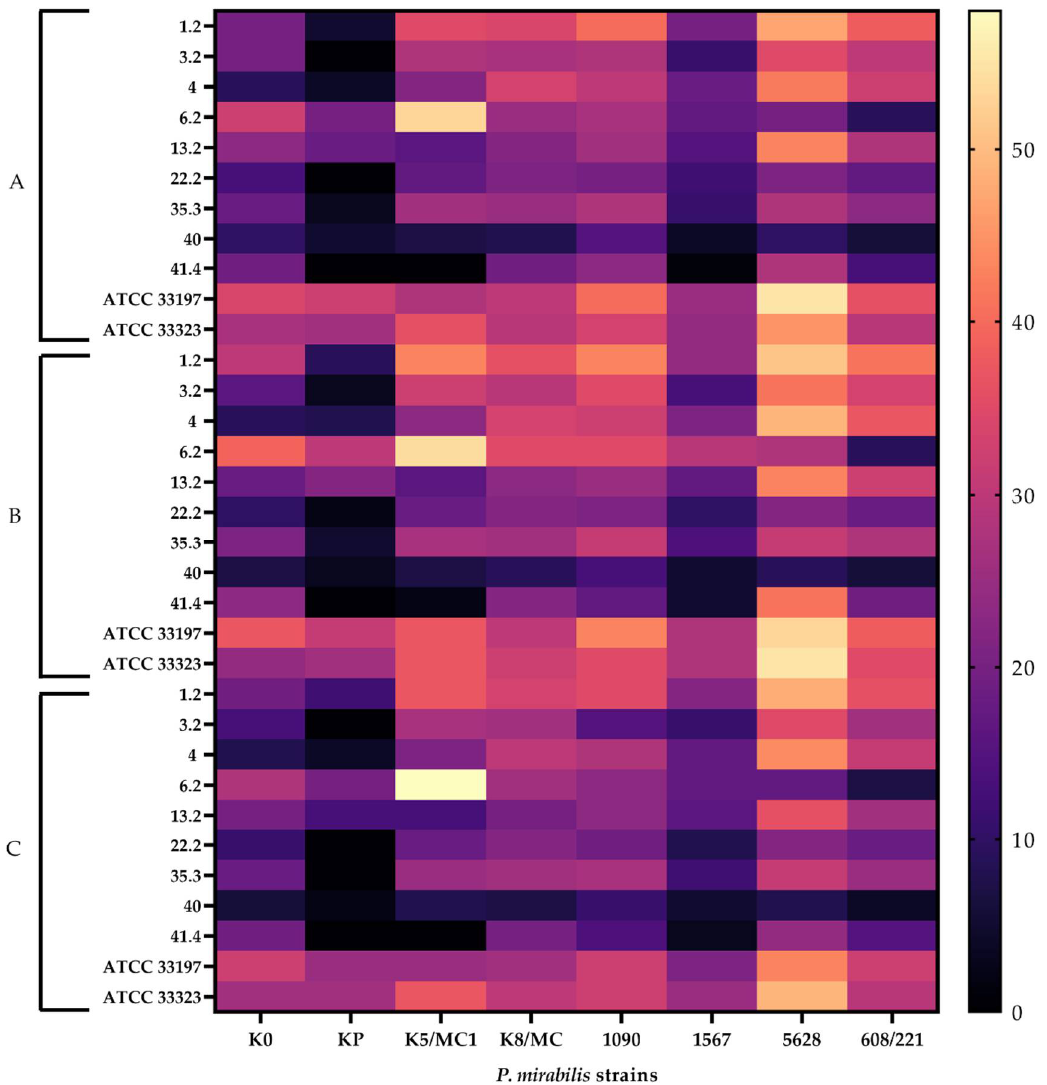
Figure 2. Heatmap of the P. mirabilis strain growth inhibition by cell-free Lactobacillus supernatants treated with different factors, expressed as percentages. ( A ) Supernatants neutralized to pH 6.0 and heated. ( B ) Supernatants only neutralized to pH 6.0. ( C ) Supernatants neutralized to pH 6.0 and treated with catalase. The results are presented as the mean ± standard deviation (SD) of three experiments, according to Cochran’s Q test.